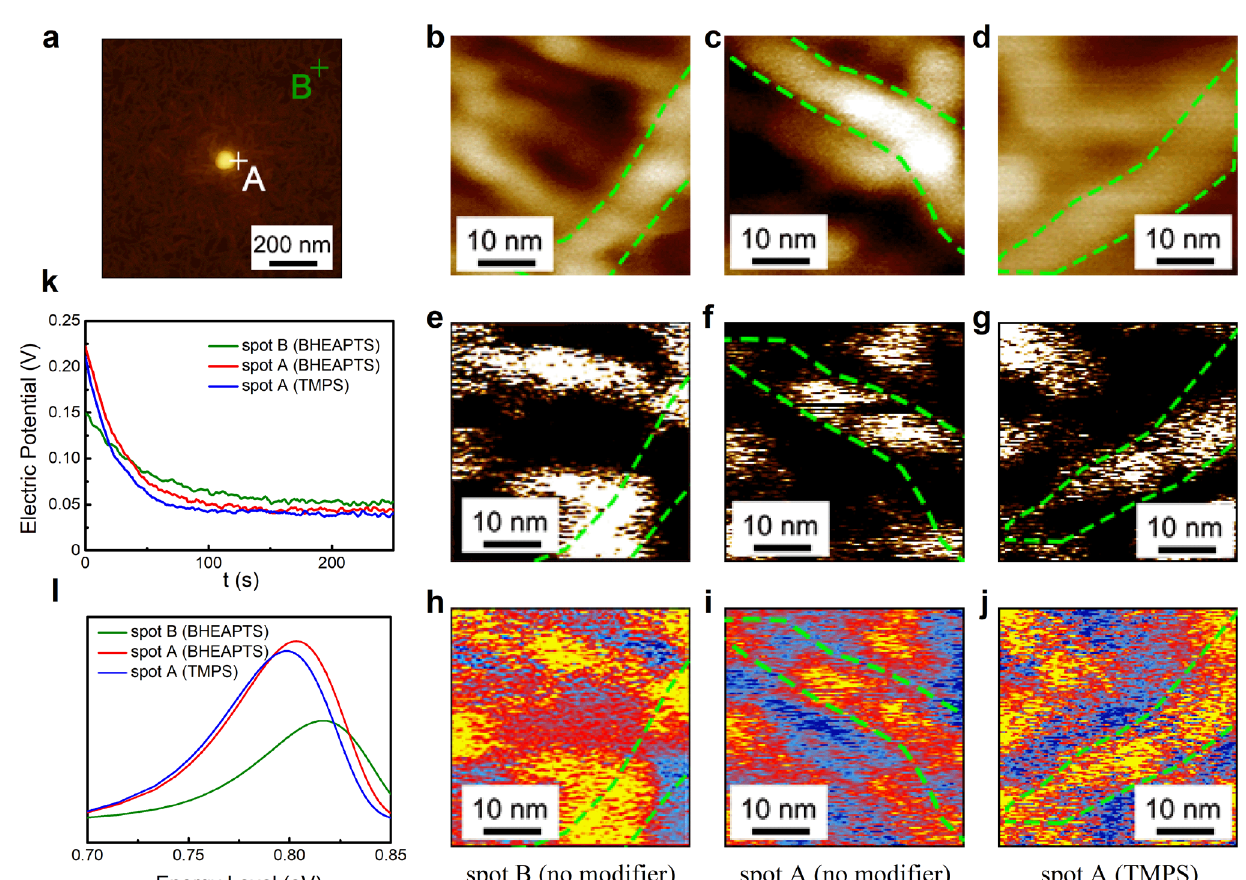
Fig. 5 a Schematic showing the location of spot A and spot B. b – d Topography, e – g PFM mappings and h – j Nano-IR mappings at spot A and spot B in different samples. k Nano-ISPD results at spot A and spot B in P(VDF-TrFE)/BTO@BHEAPTS. l Local charge trap-level distribution obtained from